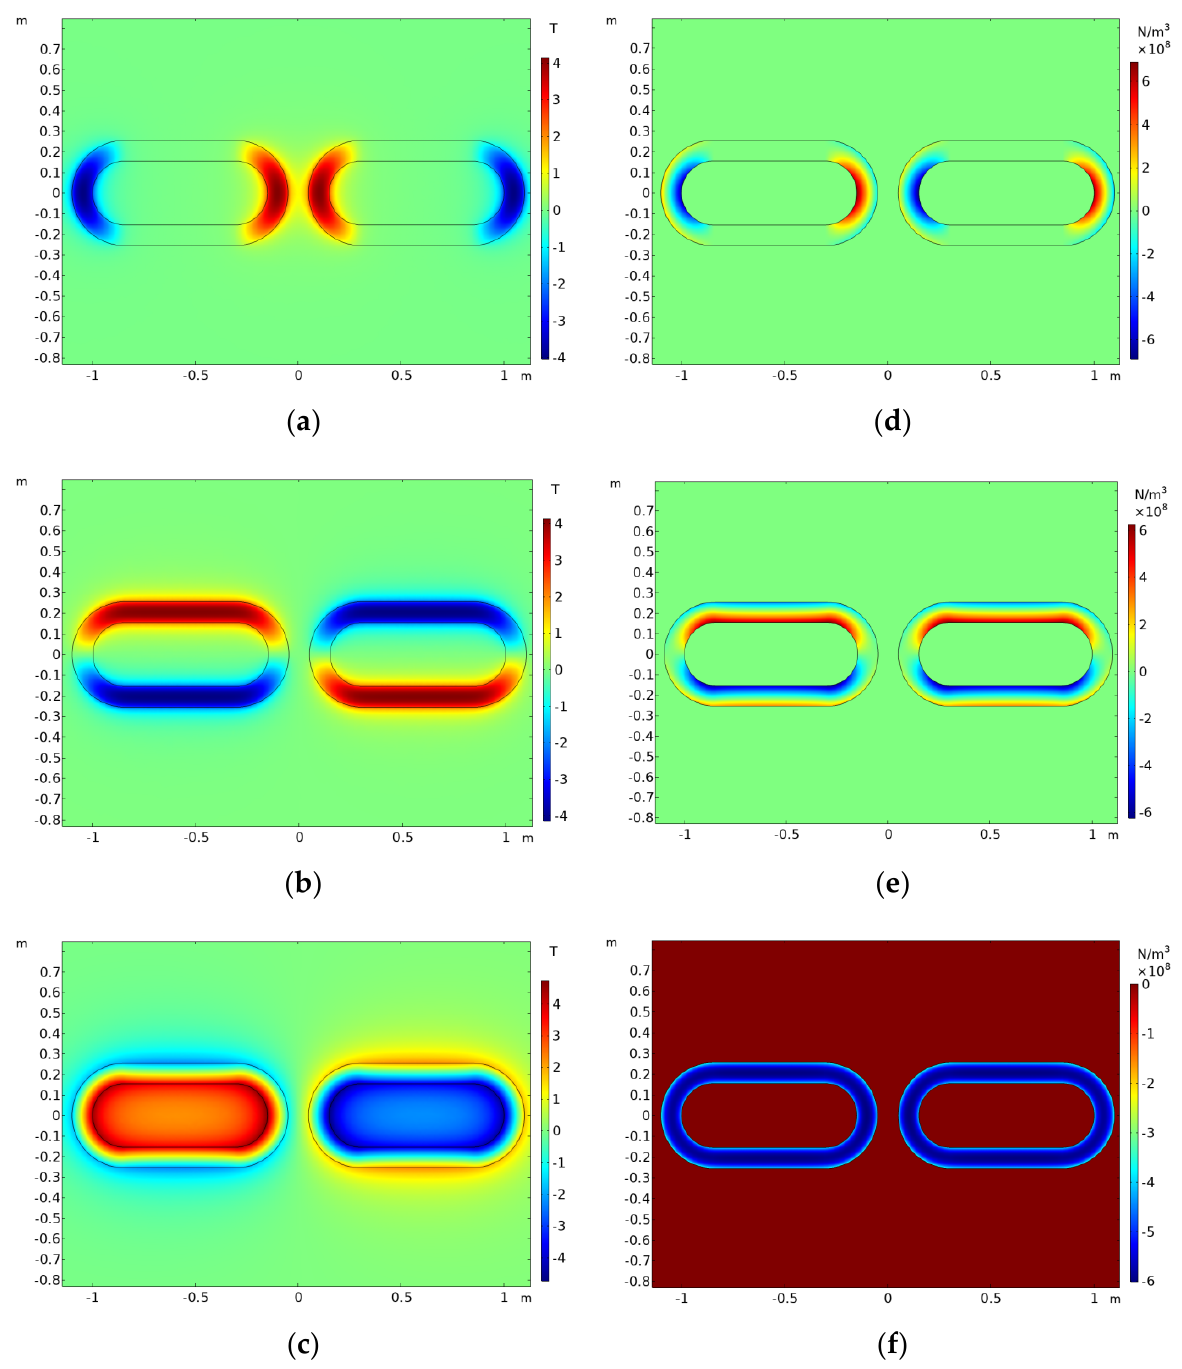
Figure 4. ( a ) Magnetic field (T) in the x -direction; ( b ) magnetic field (T) in the y -direction, ( c ) magnetic field (T) in the z -direction, ( d ) force per volume (N/m 3 × 10 8 ) in the x -direction, ( e ) force per volume (N/m 3 × 10 8 ) in the y -direction, and ( f ) force per volume (N/m 3 × 10 8 ) in the z -direction on the top surface of the HTS magnet with an operating current of 350 A. Equation (8) is the Ampere’s law, where H is the magnetic field intensity, and J is the electric current density. Equation (9) is the definition of magnetic potential, where B is the magnetic flux density, and A is the magnetic potential. Equation (10) is the constitutive relationship, where M is the magnetisation, and µ 0 is the vacuum permeability. For